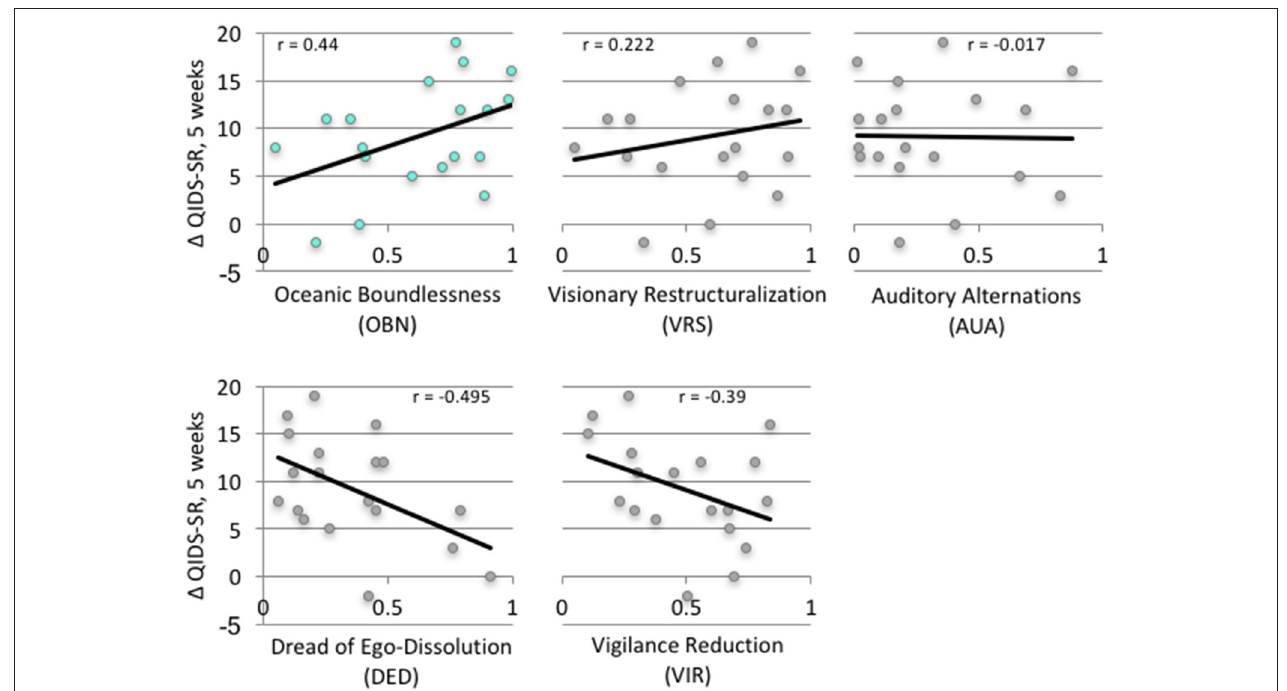
FIGURE 1 | Correlation of ASC (5 dimensions) with change of clinical outcome at 5 weeks ( 1 QIDS-SR).